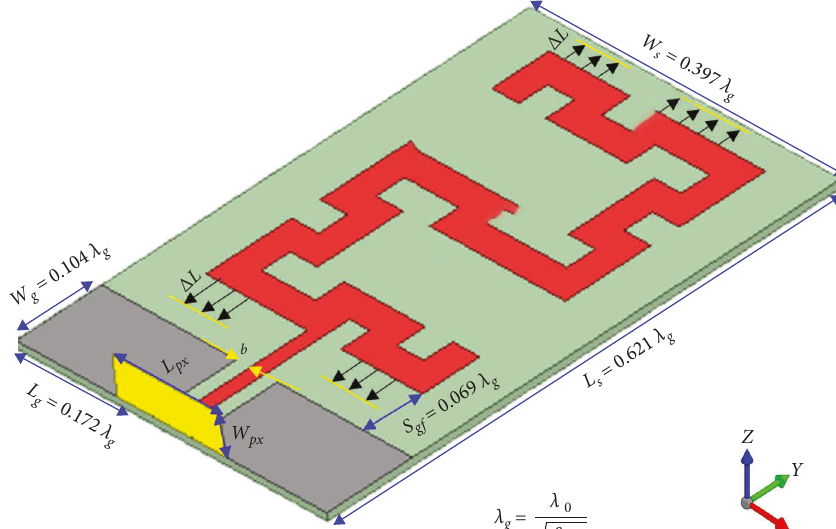
Figure 2: Proposed design of a meander-line Z -shaped monopole